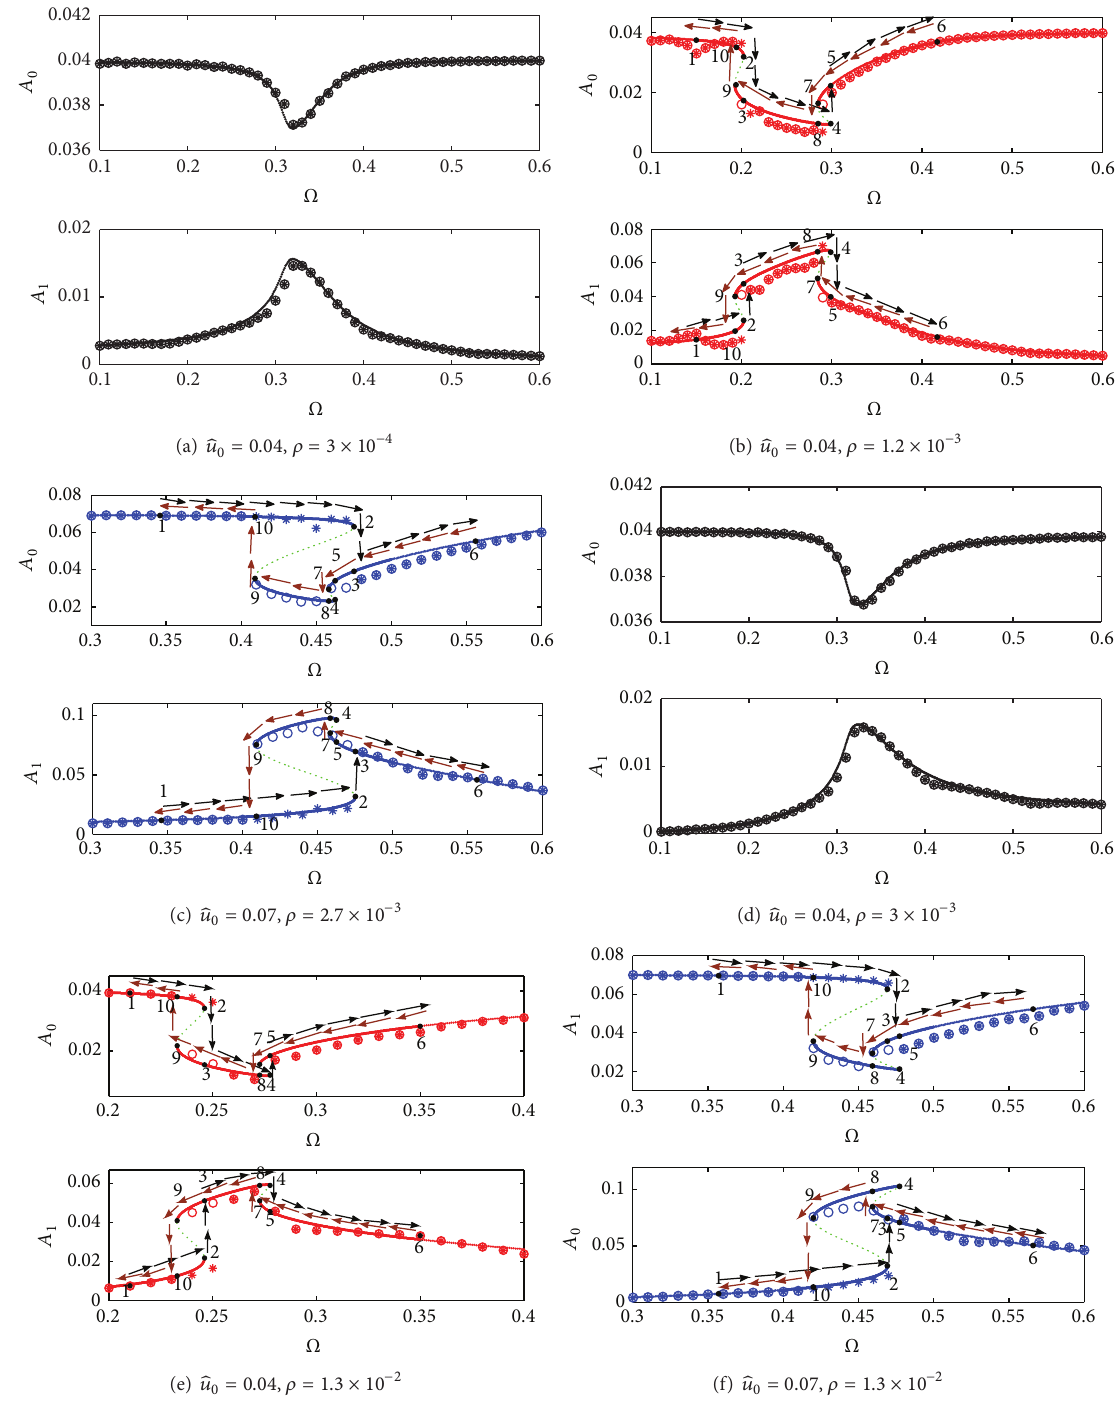
Figure 10: FRCs of the bias term 𝐴 0 and the amplitude of the harmonic term 𝐴 1 for the optimal configurative parameters and 𝜉 = 0.03 . ((a)–(c)) The force excitation; ((d)–(f)) the displacement excitation; “green dotted line” unstable solution; “ ∗ ” numerical solution obtained by increasing frequency; “ ∘ ” numerical solution obtained by decreasing